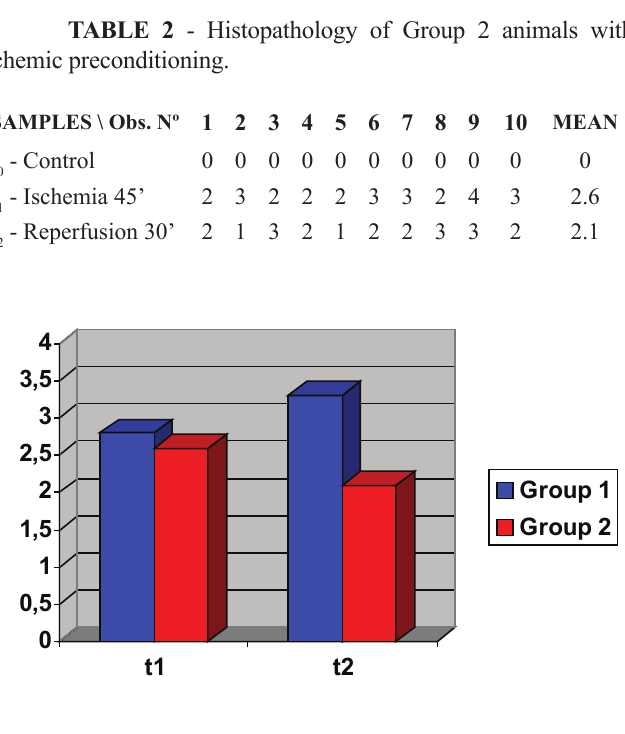
t2-30 min. reperfusion. Group 1 - Without ischemic preconditioning. Group 2 – With ischemic